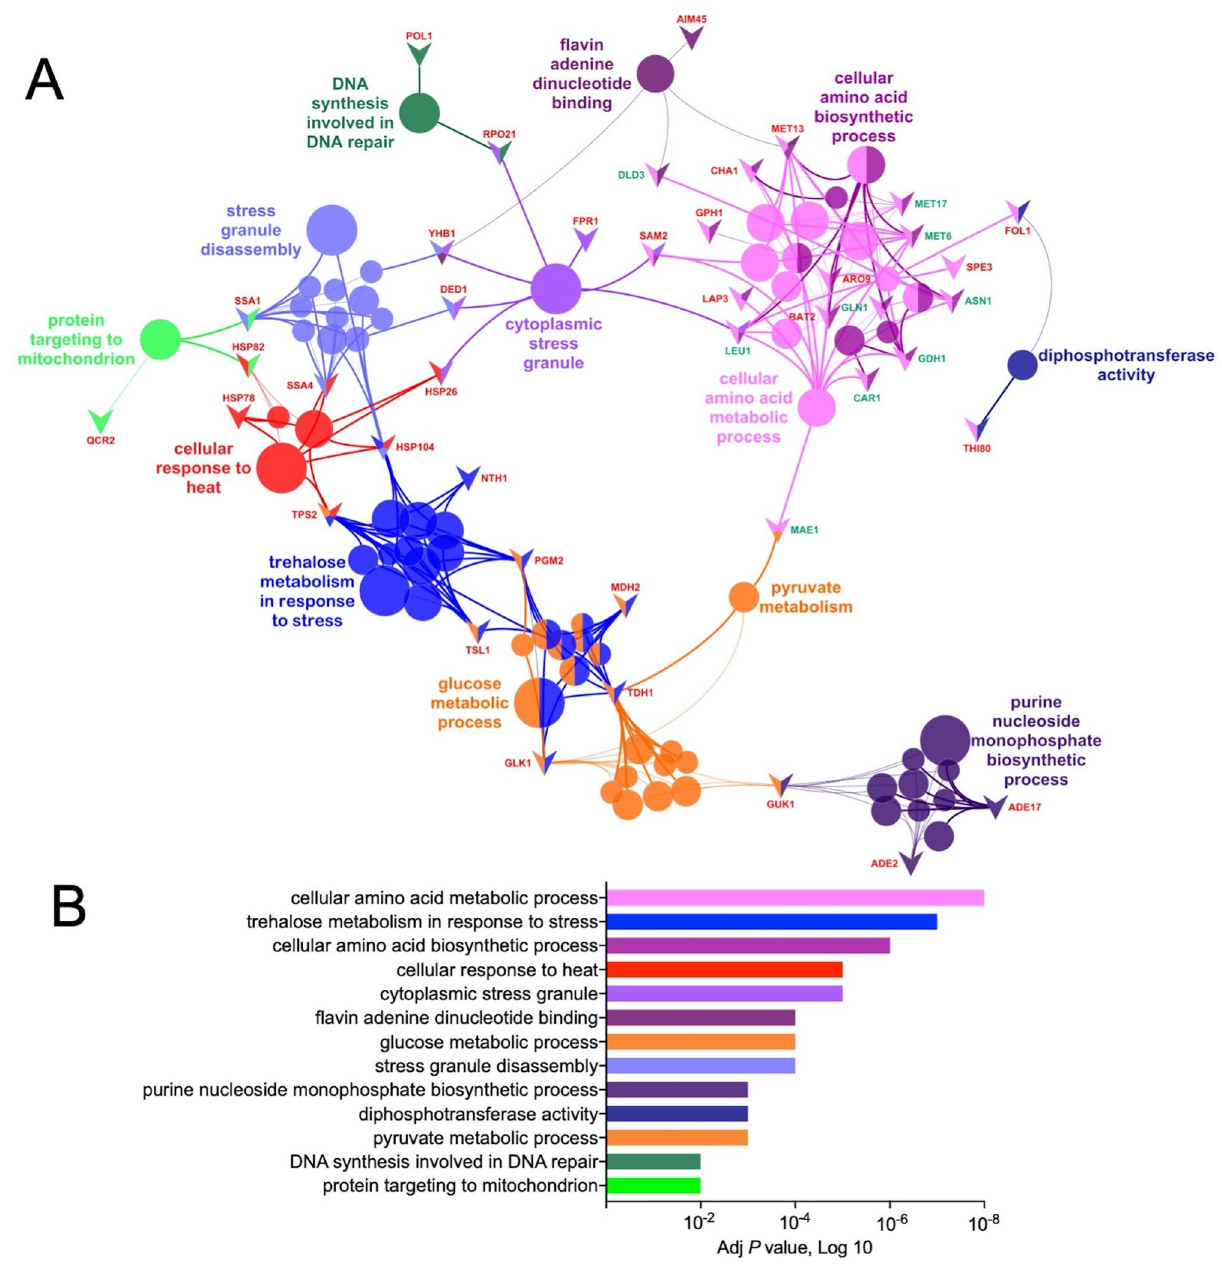
Figure 3. Functional enrichment analysis of the molecular, biological and cellular regulatory mechanisms in the mtl1Δ strain. ( A ) Network representations of GO enriched terms in the respective networks in mtl1 Δ strain of differentially expressed proteins using ClueGO. Enriched terms are represented as circle nodes based on their kappa score (> 0.4) and adjusted P values corrected with the Benjamini–Hochberg method. The enrichment significance of the GO terms is reflected by the size of the nodes. Node color represents the class that they belong. Mixed coloring means that the specific node belongs to multiple classes. Associated proteins for each term are presented as triangles. Color of the font indicates upregulation (red) or downregulation (green). The 13 top-ranked categories of GO biological processes are labeled. Sub-network terms for each category are presented in Supplementary Table S2. Visualization has been carried out using ClueGO plugin for Cytoscape 3.7.2. (https:// cytos cape. org). ( B ) Top-ranked categories visualized on a bar chart, showing adjusted P values